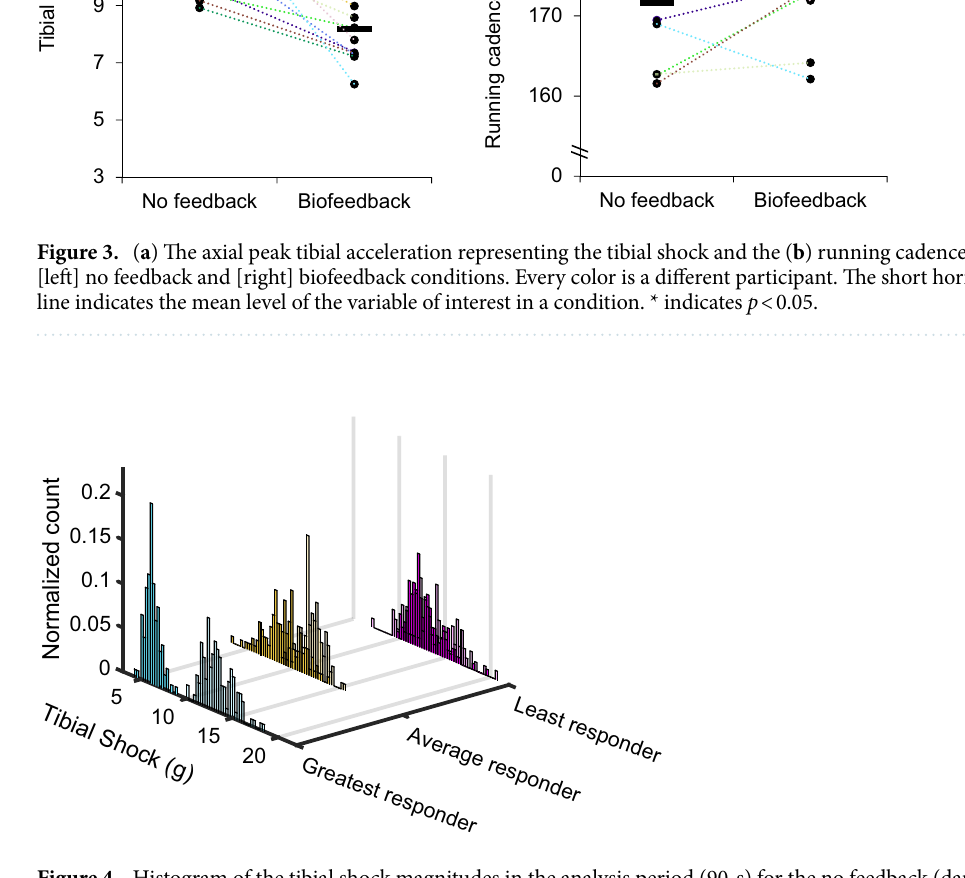
Figure 4. Histogram of the tibial shock magnitudes in the analysis period (90-s) for the no feedback (dark) and biofeedback (light) conditions in the greatest, average and least responders. The footfalls of each runner in a condition have been normalized to the number of total footfalls in that